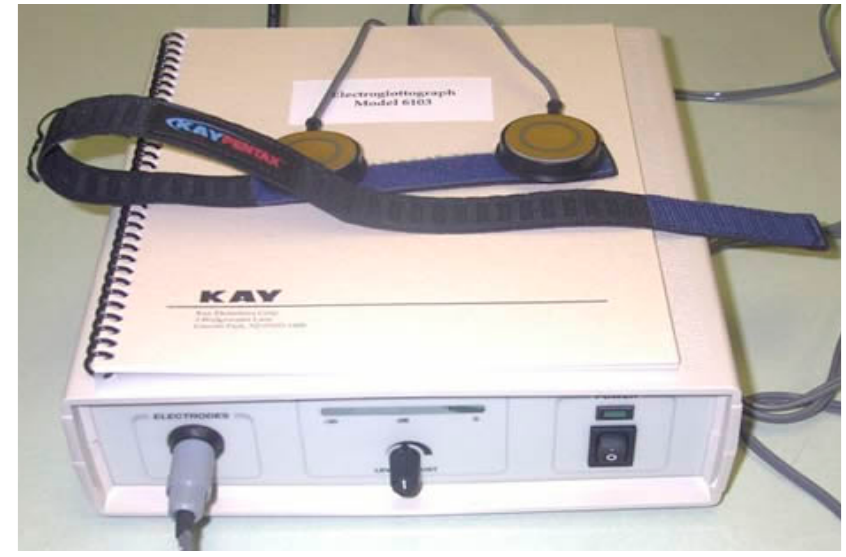
Figure 2. A standard EGG.